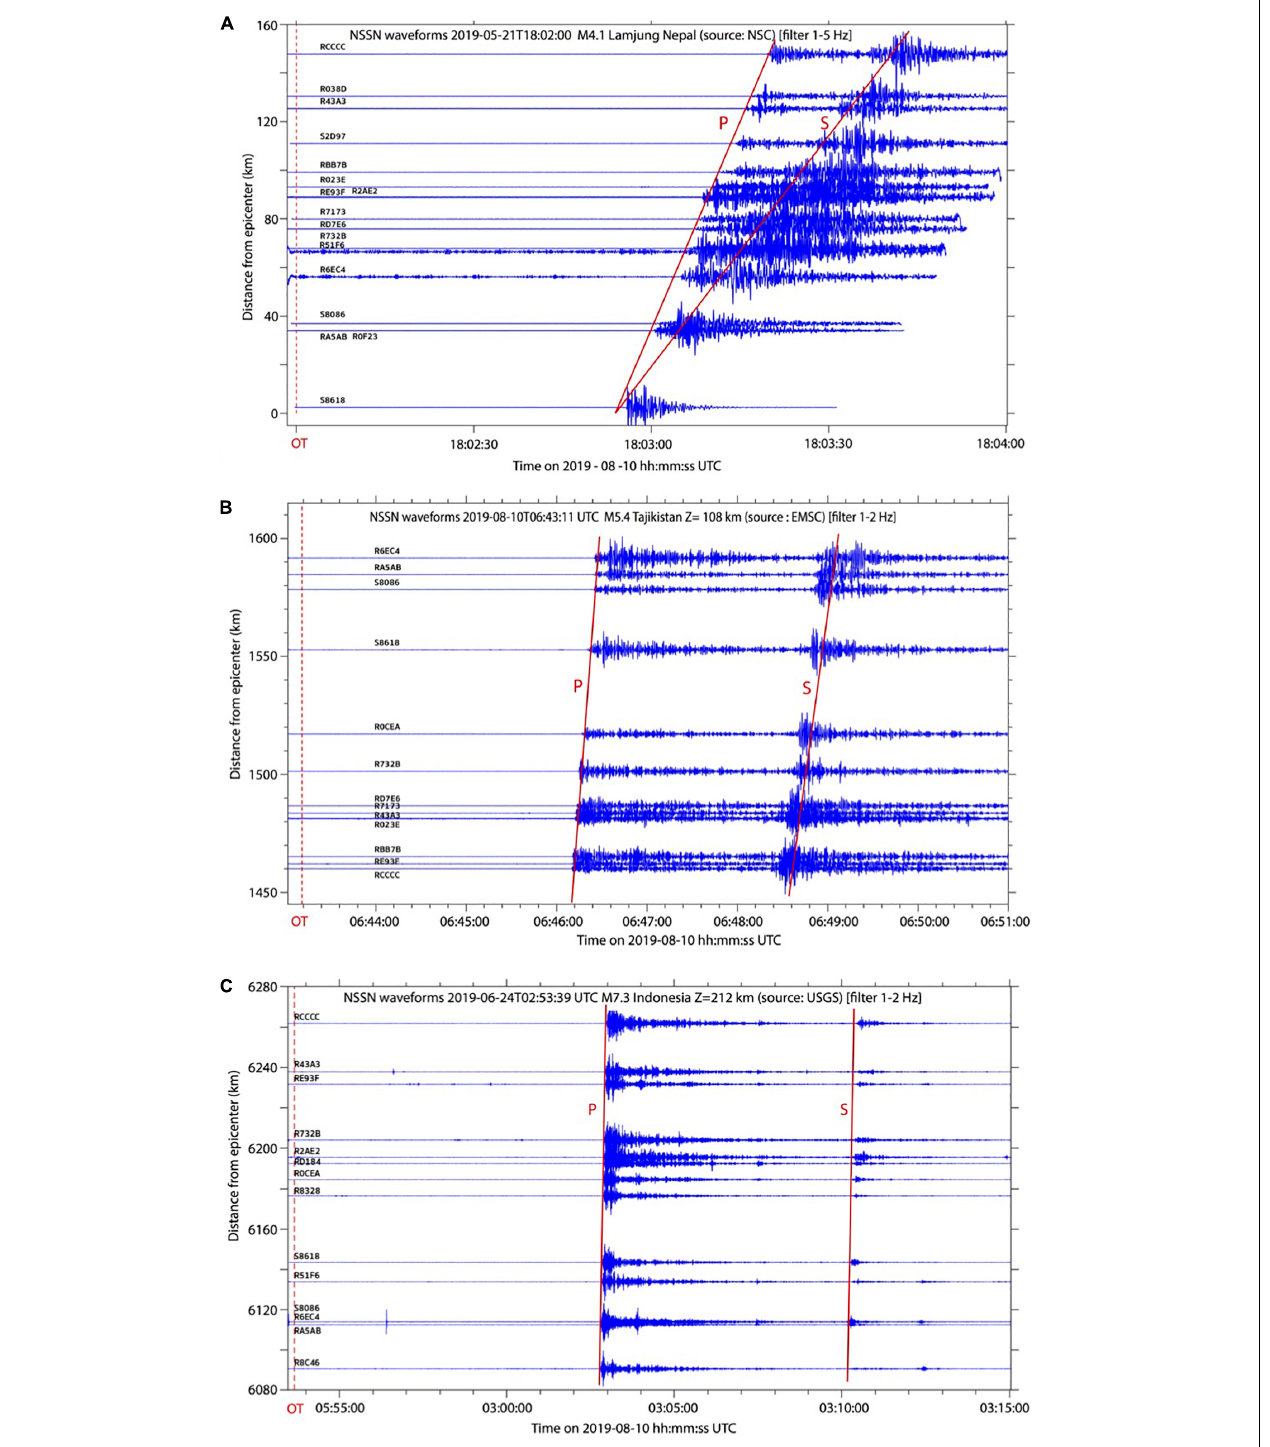
FIGURE 8 | Examples of earthquakes’ waveforms recorded by the NSSN. The dashed red line in each figure denotes the origin time of the earthquake in the available catalog. (A) Filtered waveforms in the 1–5 Hz frequency band of a local event, with solid red lines plotted for the theoretical P and S wave arrival times using local velocity model in Nepal (Pandey et al., 1995). (B,C) Waveforms of a regional event in Tajikistan and of a teleseismic event in Indonesia, filtered between 1–2 Hz. Solid red lines are plotted for the theoretical P and S wave arrival time using global iasp91 velocity model (Kennett and Engdahl, 1991). First order information of each event is written on top of each figure, including the source of the information. NSC, National Seismological Centre, Kathmandu; EMSC, European-Mediterranean Seismological Centre; USGS, United States Geological Survey. All waveforms are normalized to the same maximum amplitude.